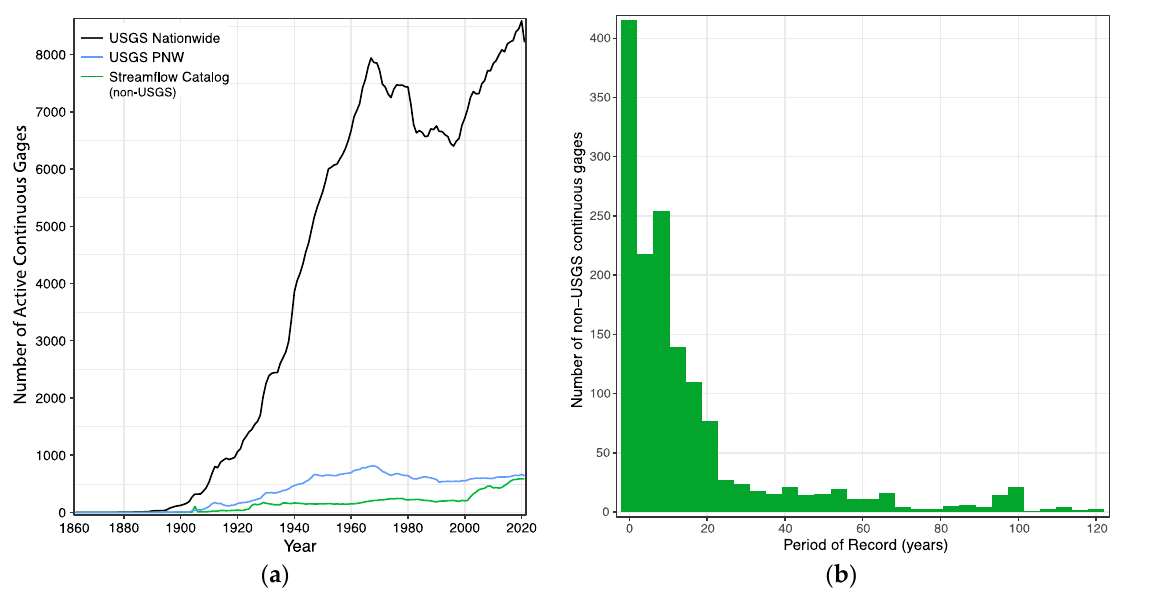
Figure 5. ( a ) Number of active, continuous streamflow monitoring locations over time operated by the USGS and Streamflow Data Catalog providers in the Pacific Northwest (Idaho, Oregon, and